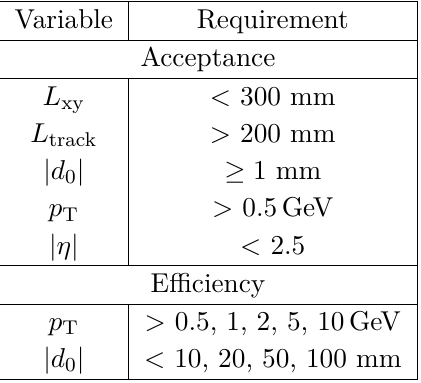
Table 2. Details of the displaced track acceptance and efficiency definitions for the Higgs portal model. The L parameter refers to the maximum allowed production radius of the track, while the xy L track variable refers the minimum track length.